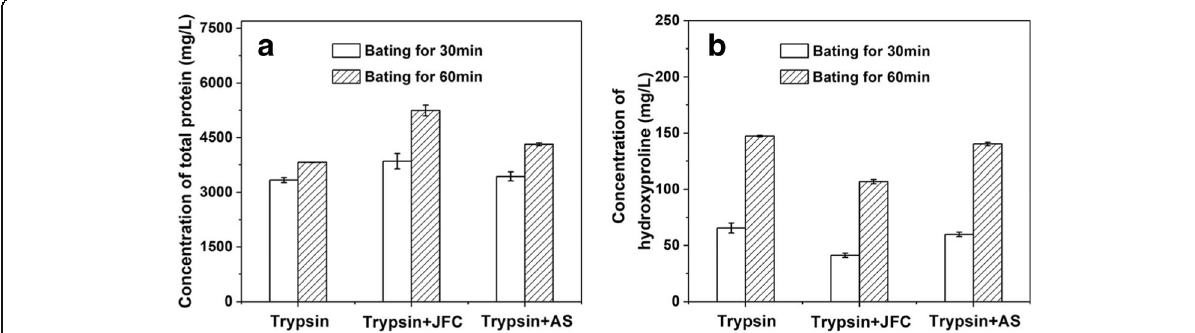
Fig. 6 Effects of JFC and AS on concentrations of total protein ( a ) and hydroxyproline ( b ) in bating effluents